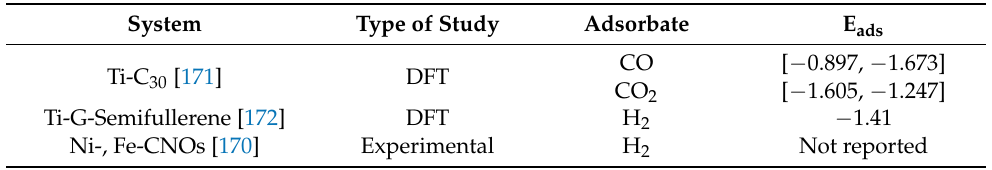
Table 11. Summary of adsorption energies E ads (in eV) for different TM-metallic doped hybrid systems and adsorbates. The type of study is also specified. System Type of Study Adsorbate